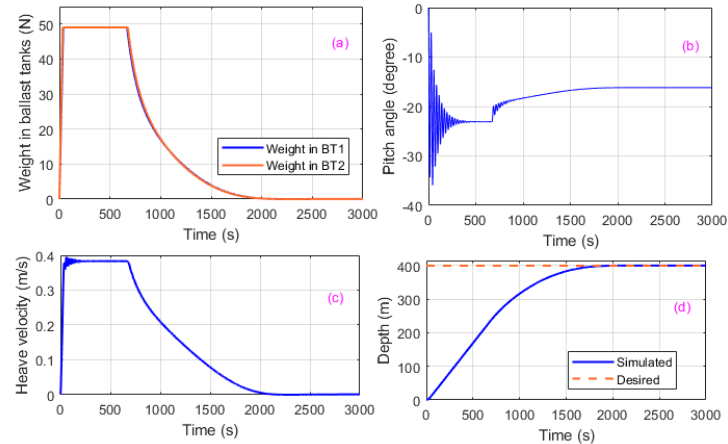
Figure 14. ( a ) Variation of the weight vs. time in both ballast tanks, ( b ) Variation of pitch angle with time, ( c ) Variation of sinking (heave) velocity with time and ( d ) Variation of depth with time in closed loop.